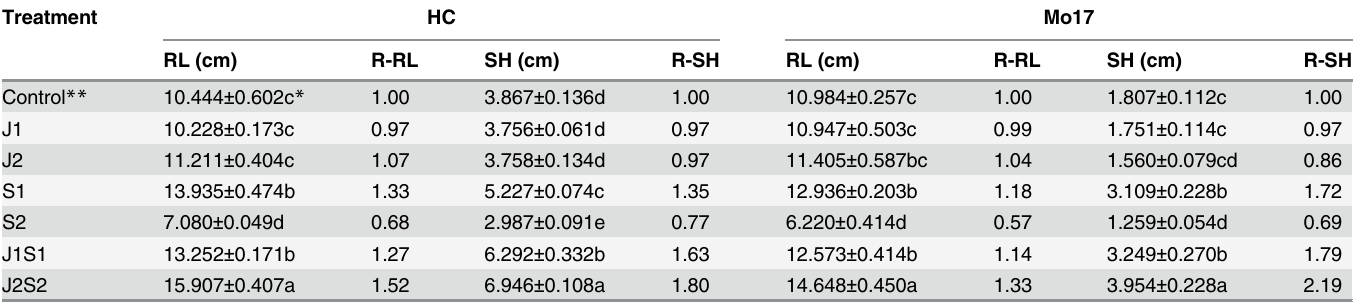
Table 3. Effect of coating agent on maize root length and shoot height under chilling stress. Treatment